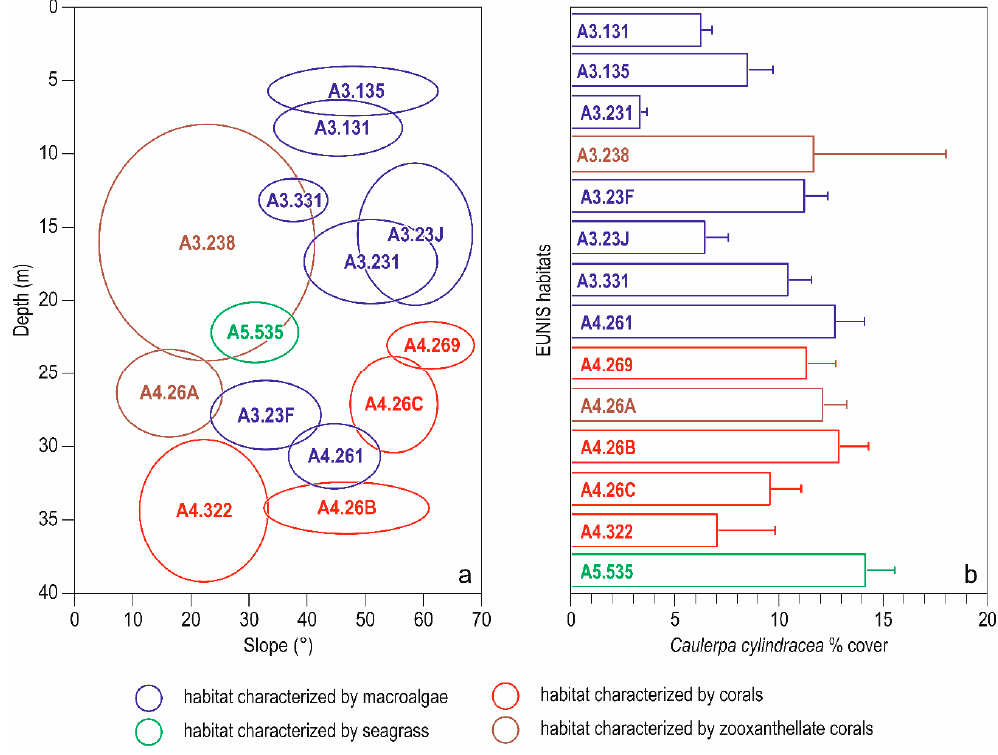
Figure 5. EUNIS habitats in Portofino MPA and incidence of Caulerpa cylindracea (from the comprehensive database of 78 species × 229 samples): ( a ) Depth and slope preferences of the 14 EUNIS habitats identified on the rocky reefs of Portofino. See Table 1 for habitat codes and extended names. Codes are centered on mean values, while ellipses depict the 95% confidence region (the two axes of the ellipses represent confidence limits for depth and slope, respectively); ( b ) mean % cover of C. cylindracea in the 14 EUNIS habitats (error bars represent 1 standard error). For the number of samples belonging to each EUNIS habitat see Table 1 (column n ). Table 1. EUNIS habitats recognized in the rocky reefs of Portofino MPA between 1 m and 45 m depth. Here, n is the number of samples belonging to a specific EUNIS habitat. Where necessary (e.g., nomenclatural updates), extended names have been emended with respect to the original ones.